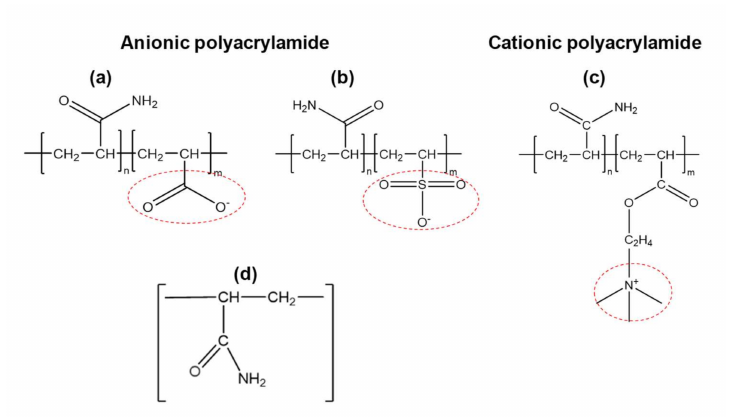
Figure 1. Chemical structures of non-ionic, anionic (carboxylated ( a ) and sulfonated ( b )), cationic polyacrylamides ( c ), and amide group ( d